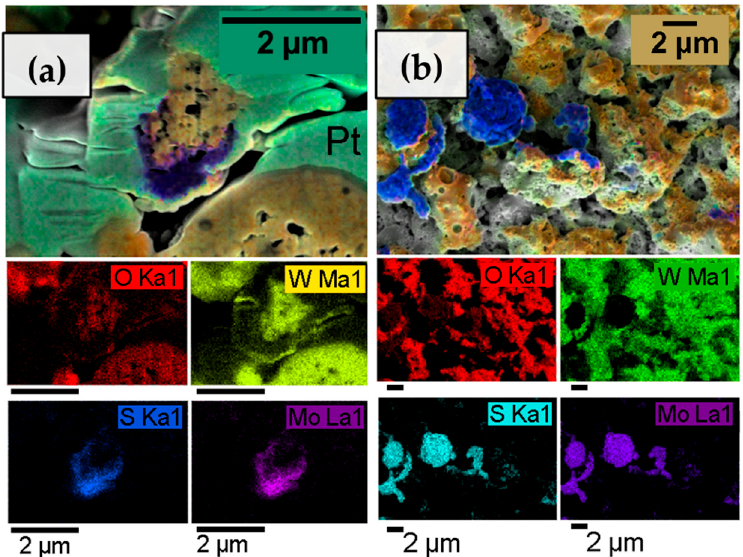
Figure 4. EDX elemental composition maps of 30-min-WO 3 /MoS x heterostructured coating. Cross- sectional view ( a ), and top-down view ( b